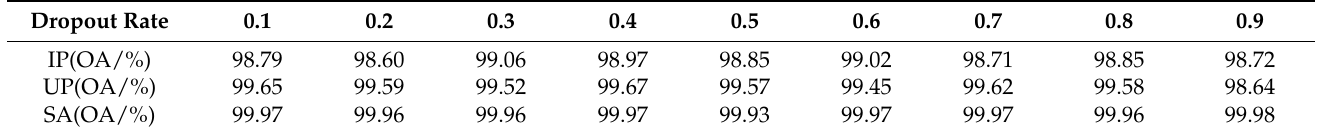
Table 4. Different dropout